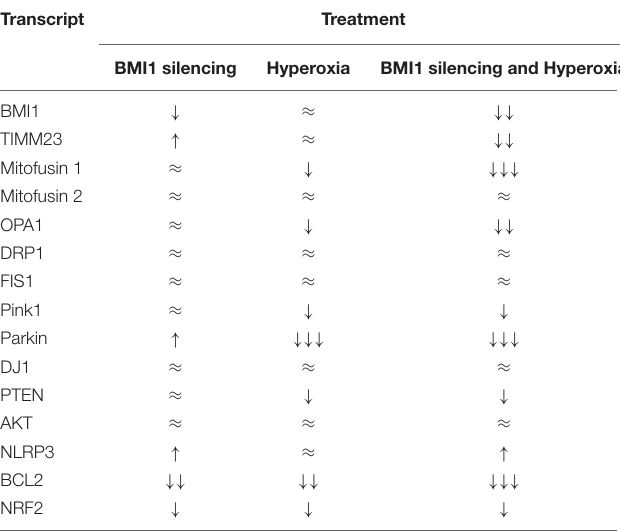
TABLE 4 | Effect of Hyperoxia and BMI1 silencing in gene transcripts levels based on simple comparisons analysis.